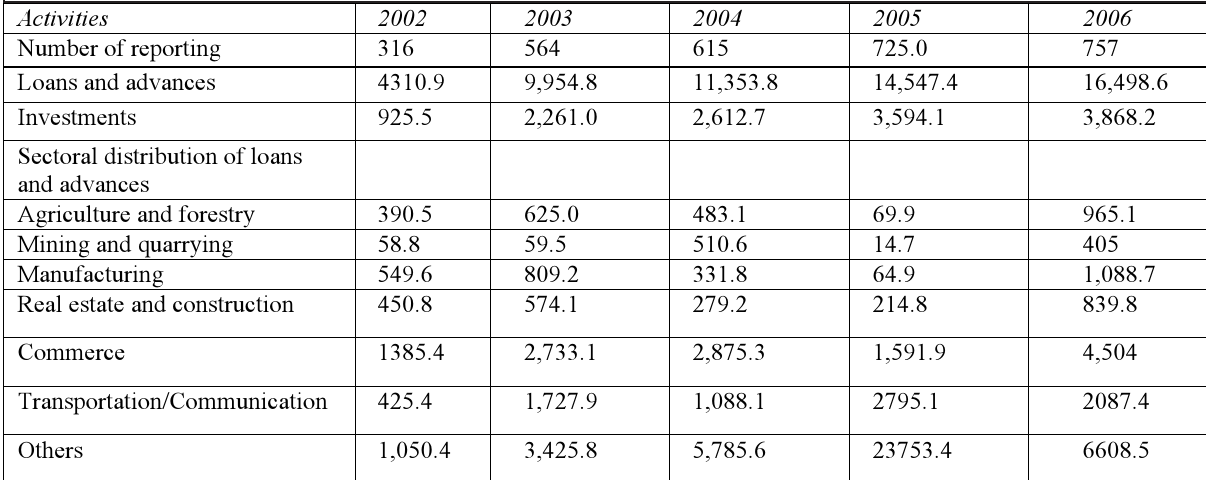
Table 2. Summary of Community Banks’ Activities (Naira million, unless otherwise stated) Source: CBN, 2006a.